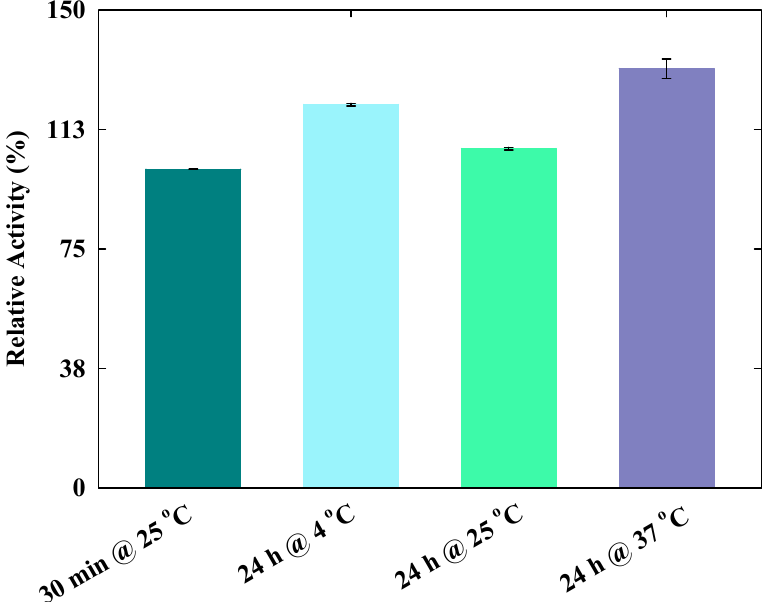
Figure 2. Lysozyme relative activity at different incubation conditions. The error bars indicate the standard deviations of the mean values.